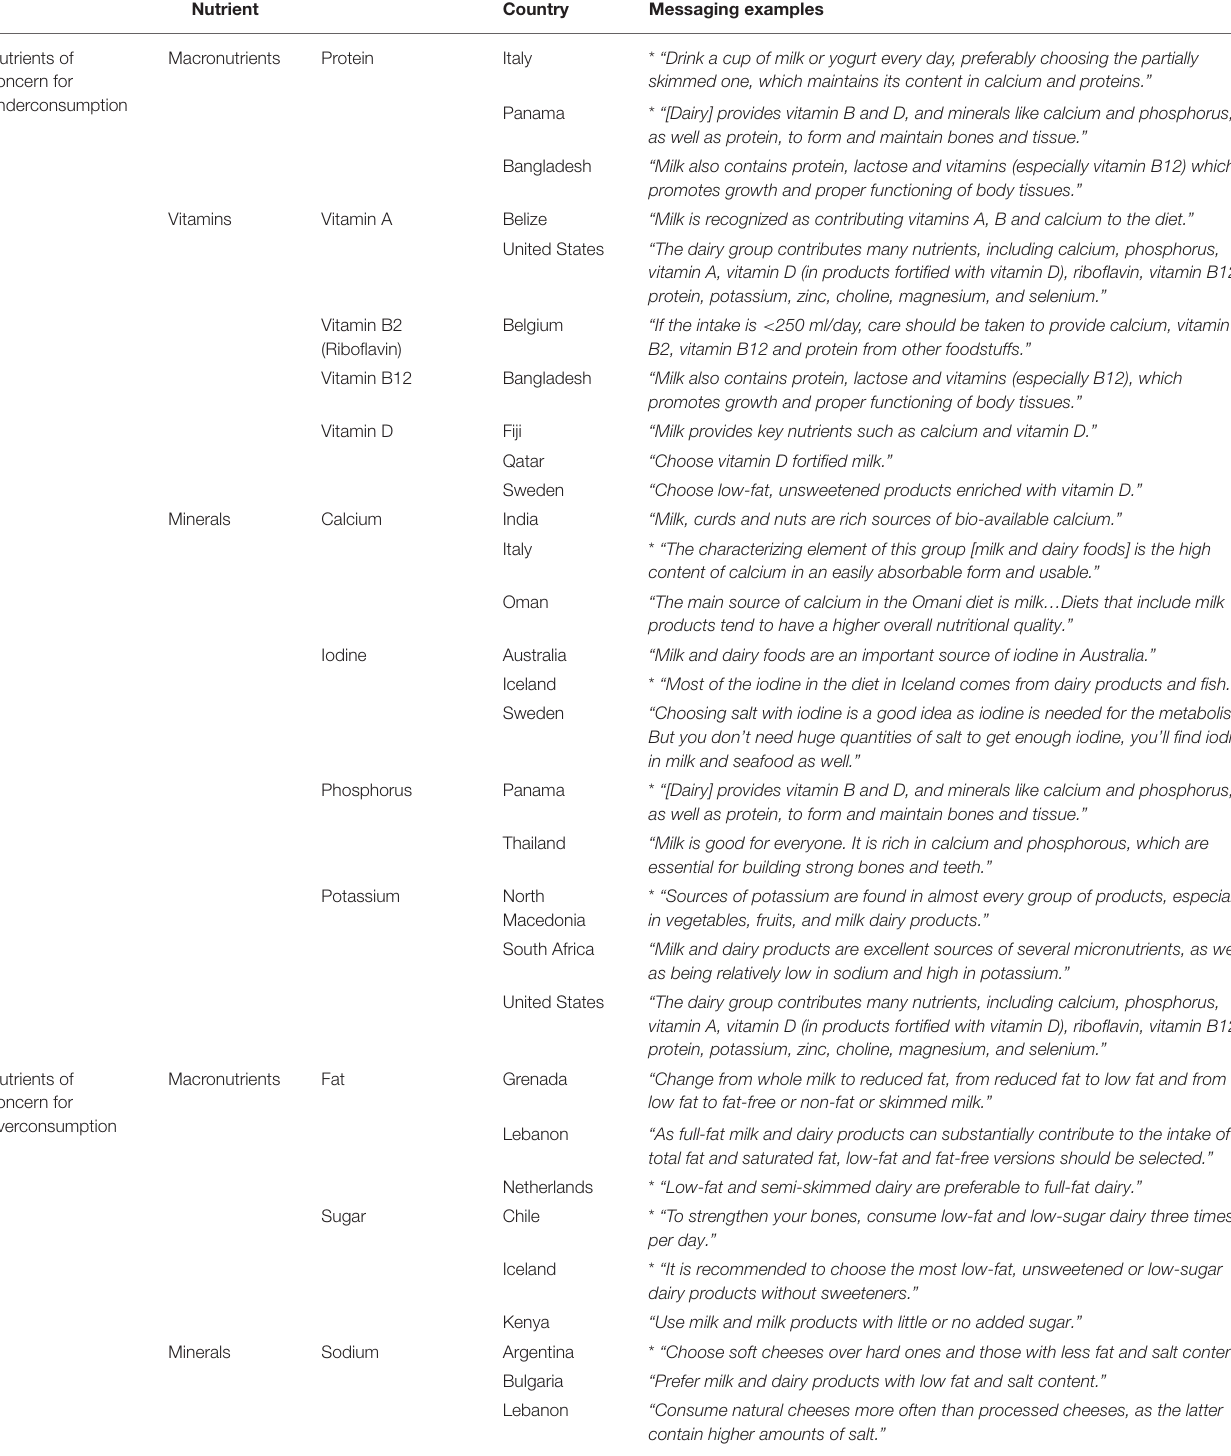
TABLE 2 | Examples of milk and dairy nutrient-based messaging in FBDGs. Nutrient